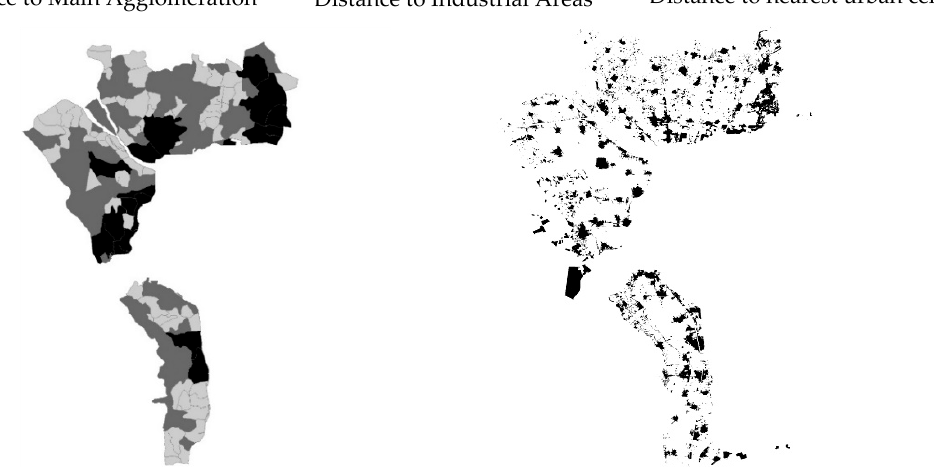
Figure 3. Raster layers of independent variables.